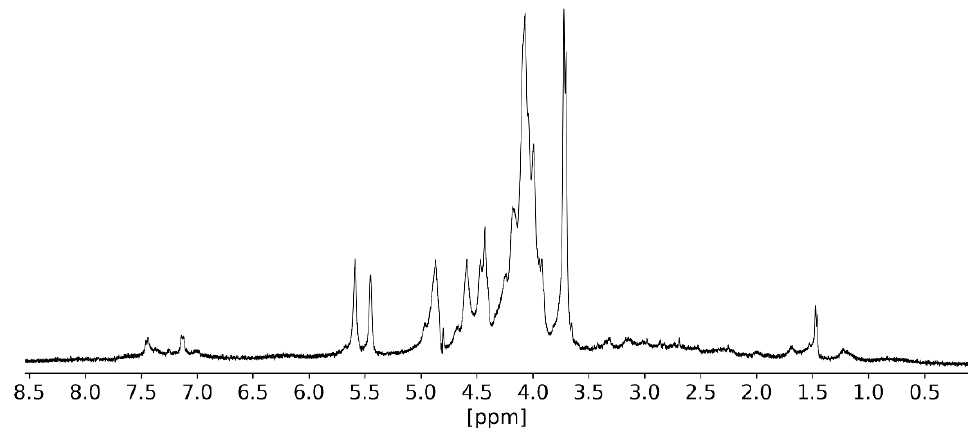
Figure 5. 1 H NMR spectrum of POR-L2 with suppression of the D 2 O residual signal. The observation of galactose-6- O -L2 units was attempted by long-range COSY (Figure 6)